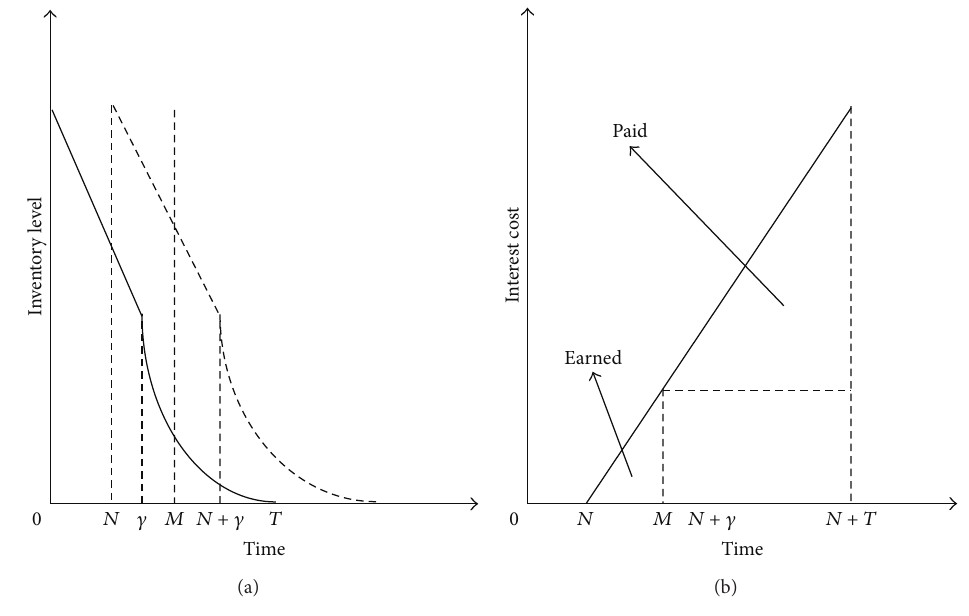
Figure 7: Inventory system for Case 2 when 𝑇 ≥ 𝛾